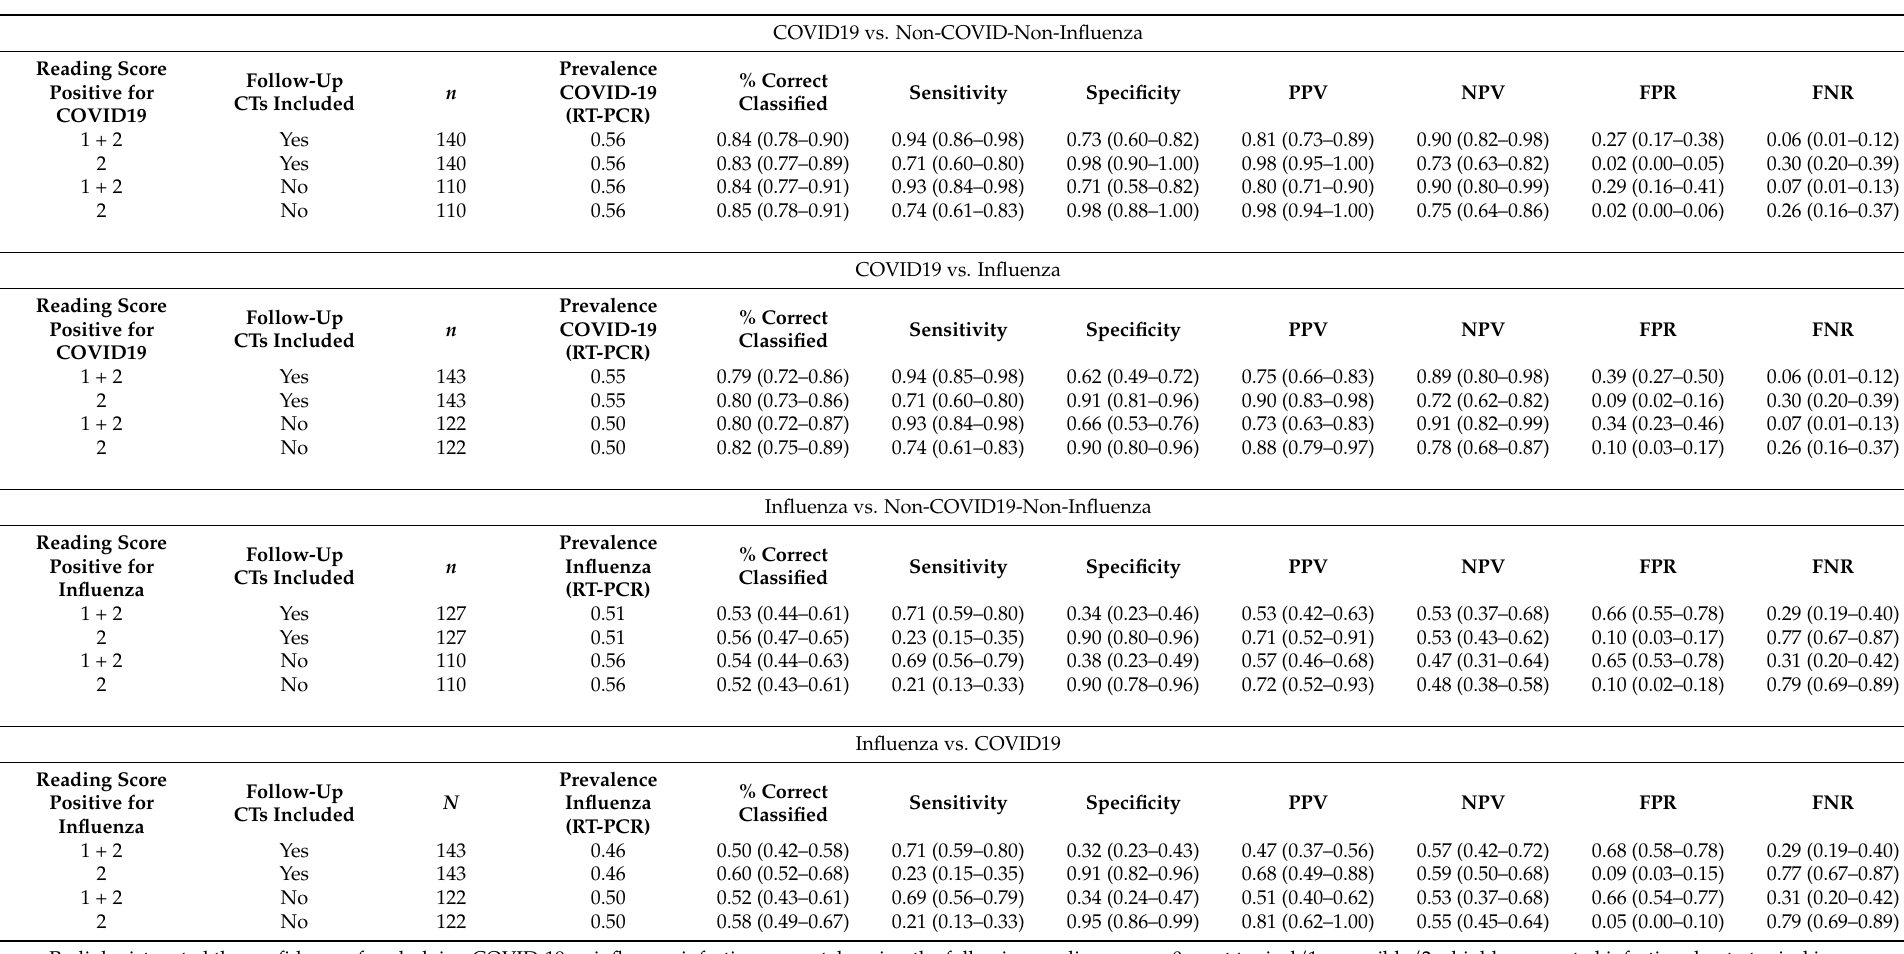
Table 2. Radiologist’s Diagnostic Metrics (Subgroup Analysis) for the Classification of Atypical Pneumonias according to Assumed COVID-19 or Influenza Infection. COVID19 vs.